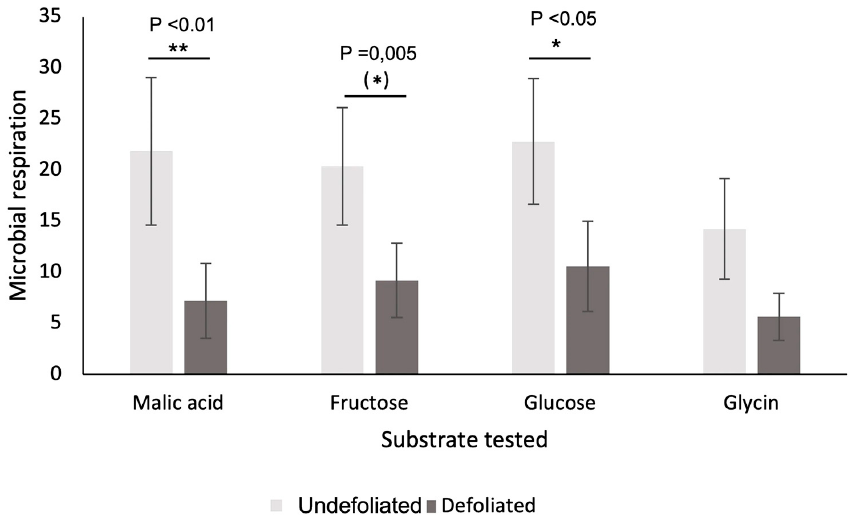
Figure 2. Mean microbial respiration ( µ g CO 2 -C g − 1 soil hour − 1 ) ± standard error from carbon- based substrate-induced respiration of the top 5 cm of soil sampled under undefoliated (N = 8) and defoliated (N = 7) Populus tremuloides trees. An ANOVA found significative differences between defoliated and undefoliated trees across substrates, Tukey’s test found the difference was significative for every substrate except glycin. Soils were sampled in August 2018 in the Lake Duparquet Research and Teaching Forest (Abitibi, QC, Canada). * p < 0.05 and ** p < 0.01 indicate a significant post hoc Tukey